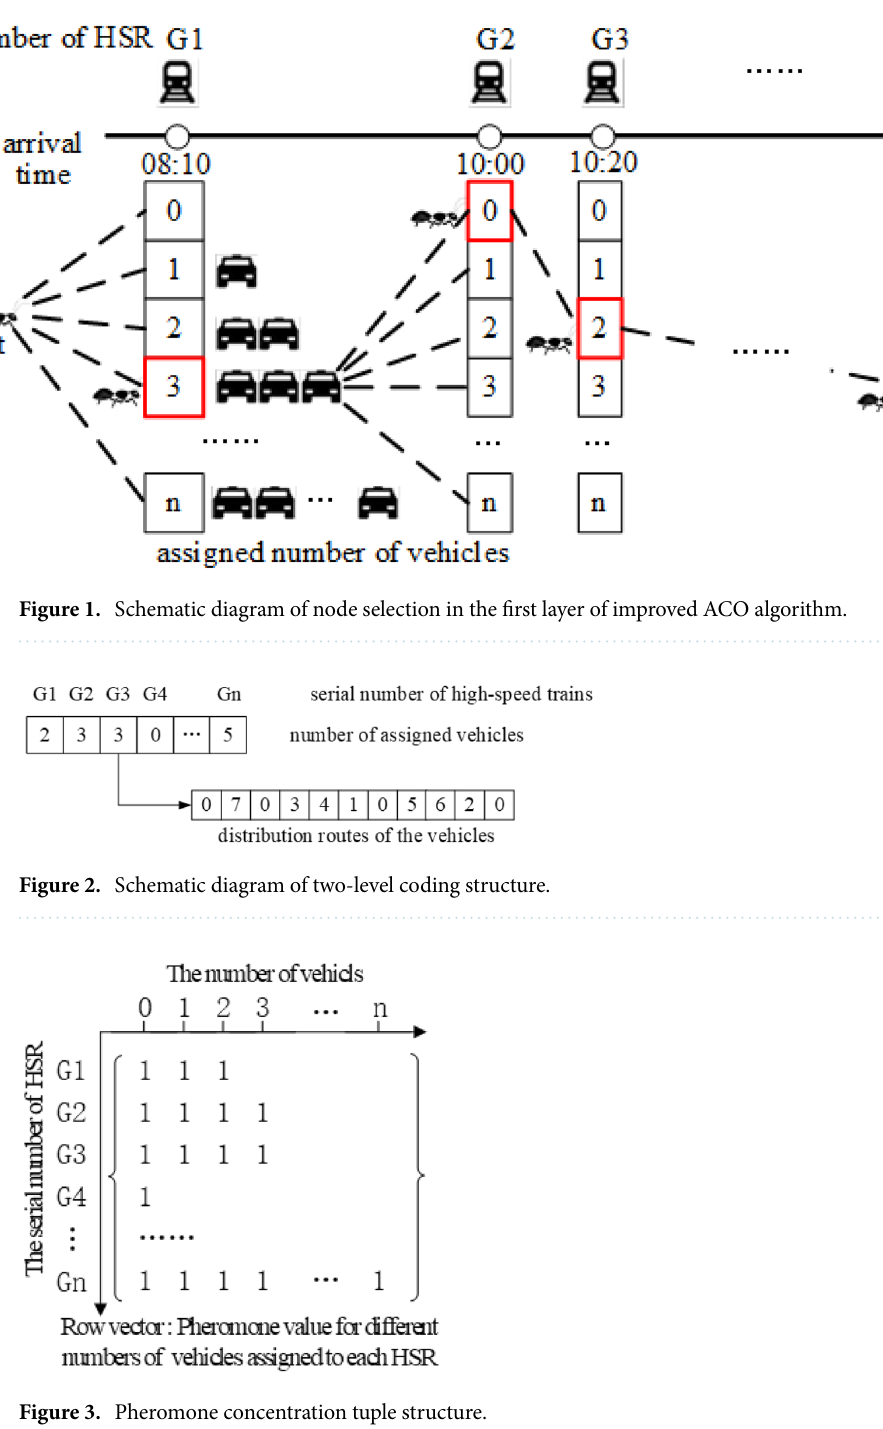
Figure 3. Pheromone concentration tuple